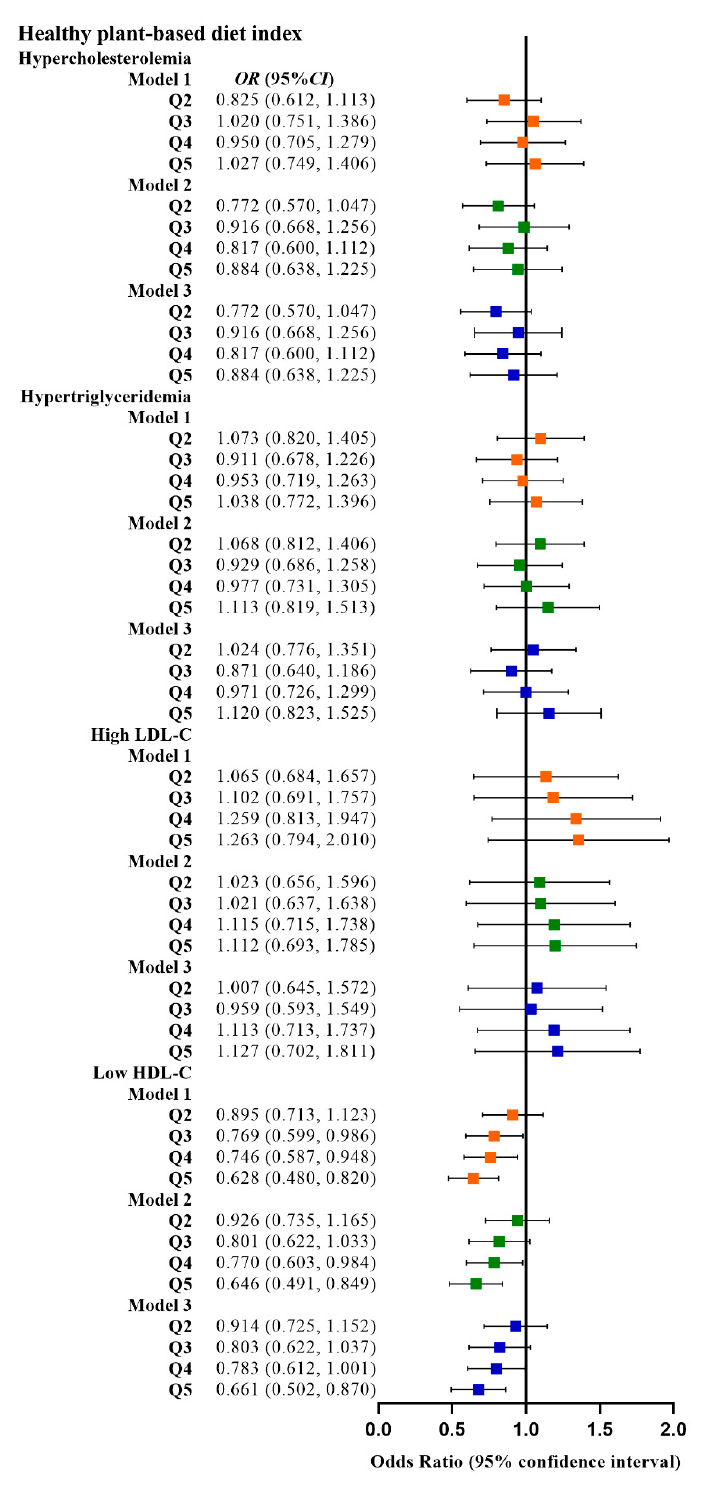
Figure 3. Odds ratios (OR) and 95% confidence intervals (CI) for hPDI with different types of dyslipidemia. The squares show odds ratios and the line ranges show 95% confidence intervals. Model 1: unadjusted; model 2: adjusted for sex, age, ethnicity, BMI, socio-economic status, smoking status, alcohol consumption, and physical activity; model 3: additionally adjusted for T2DM and hypertension.